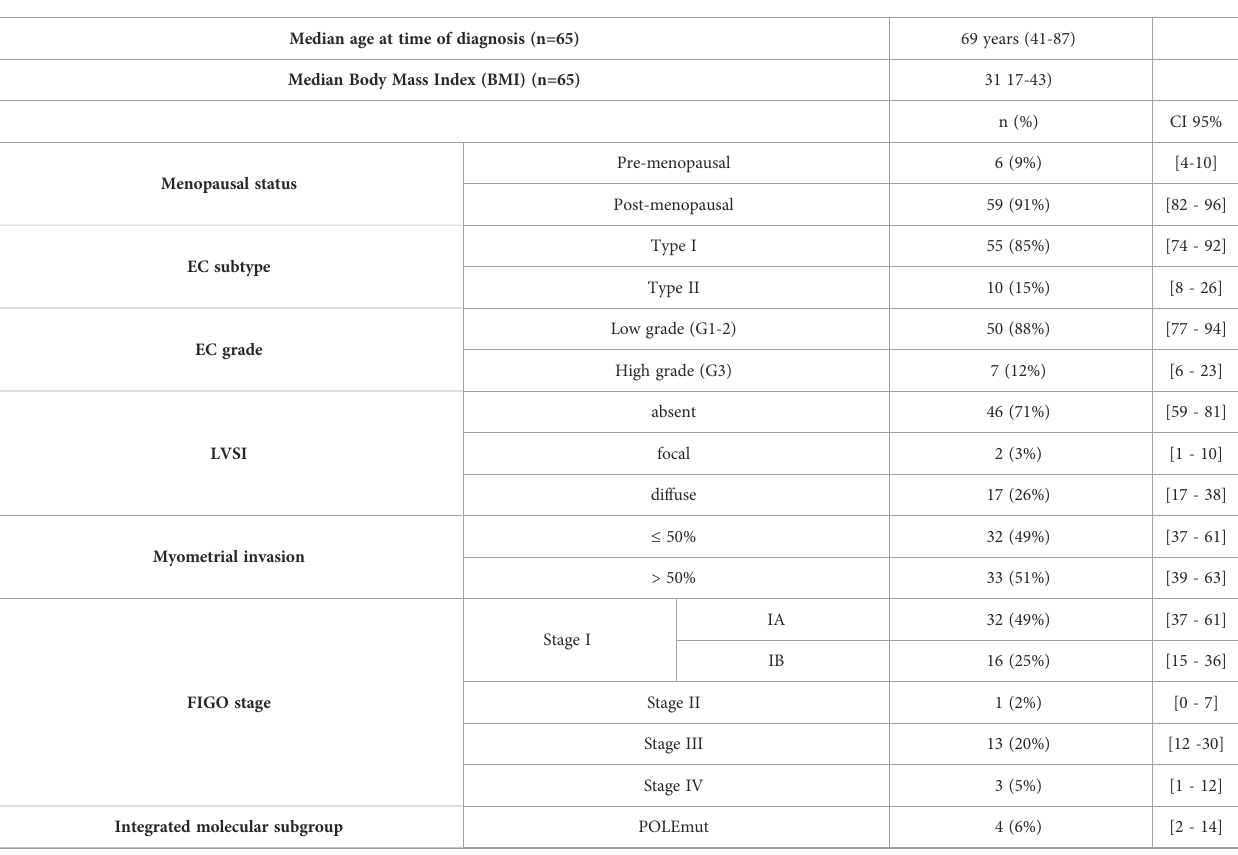
TABLE 1 Patient characteristics.